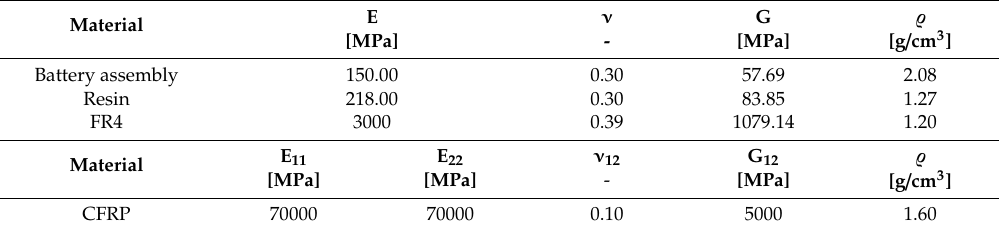
Figure 5. FE models mesh: ( a ) Cellular configuration; ( b ) Commercial Electrical Power System (EPS) architecture. Table 3. Materials mechanical properties for the Finite Element (FE)